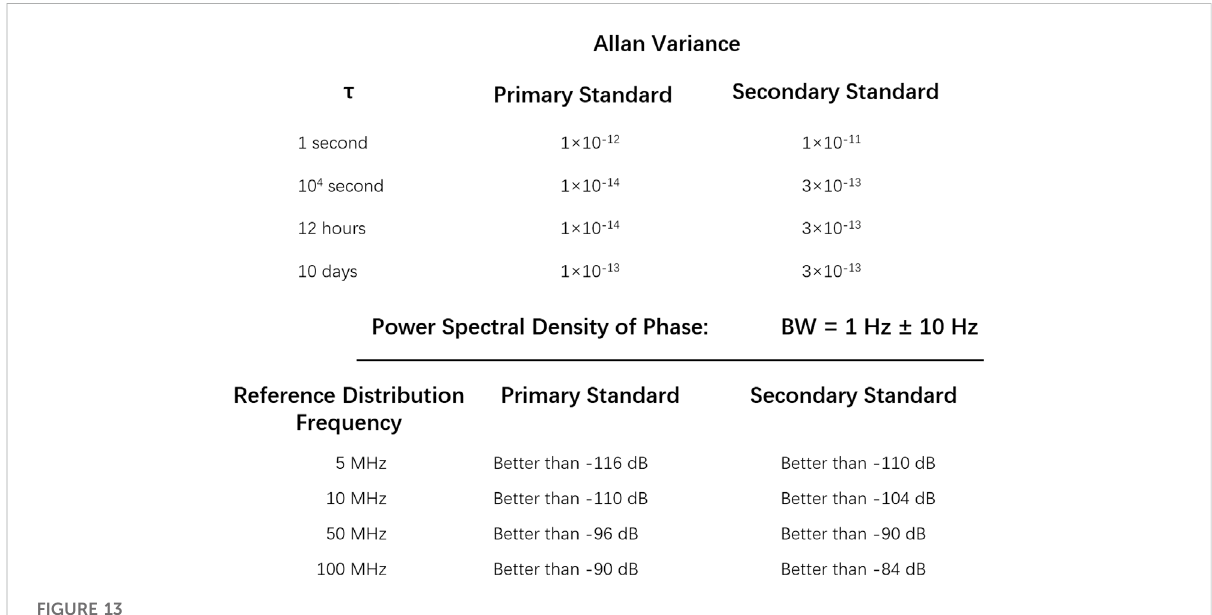
FIGURE 13 Frequency standard requirements, 1981 –